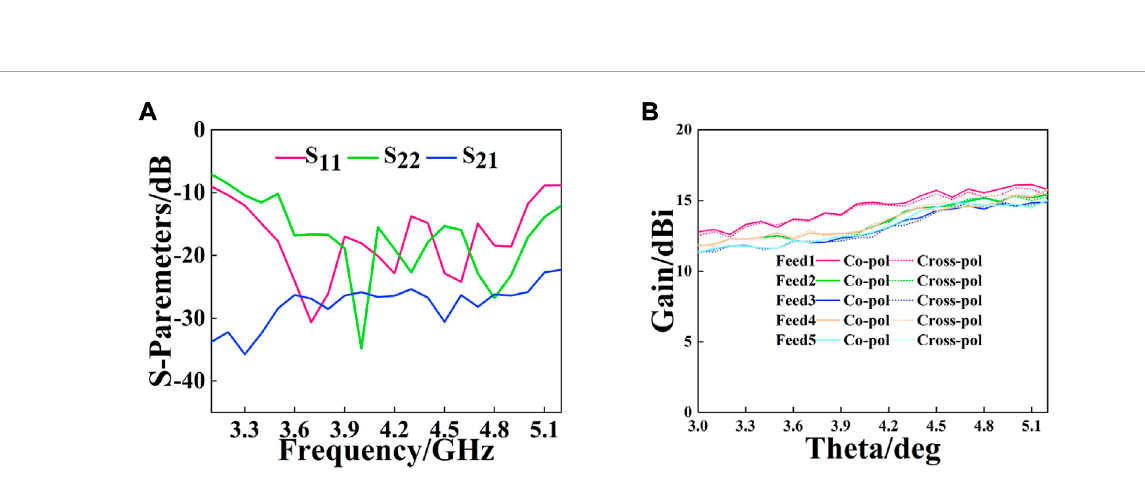
FIGURE 8 Measured results of the proposed Luneburg lens. (A) S-Parameters. (B) Gain